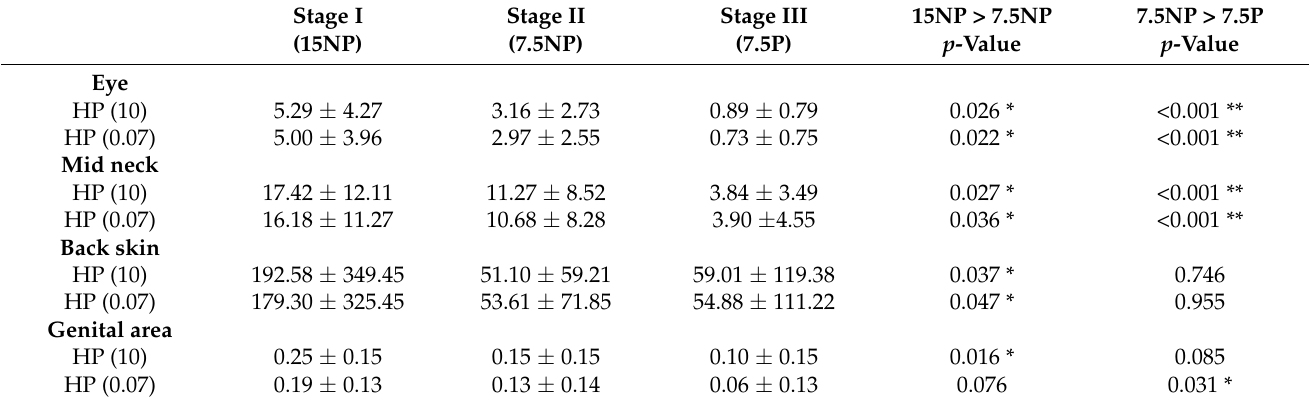
Table 2. Measured radiation dose ( µ Sv) over the eye, mid neck, back skin, and genital area at three different